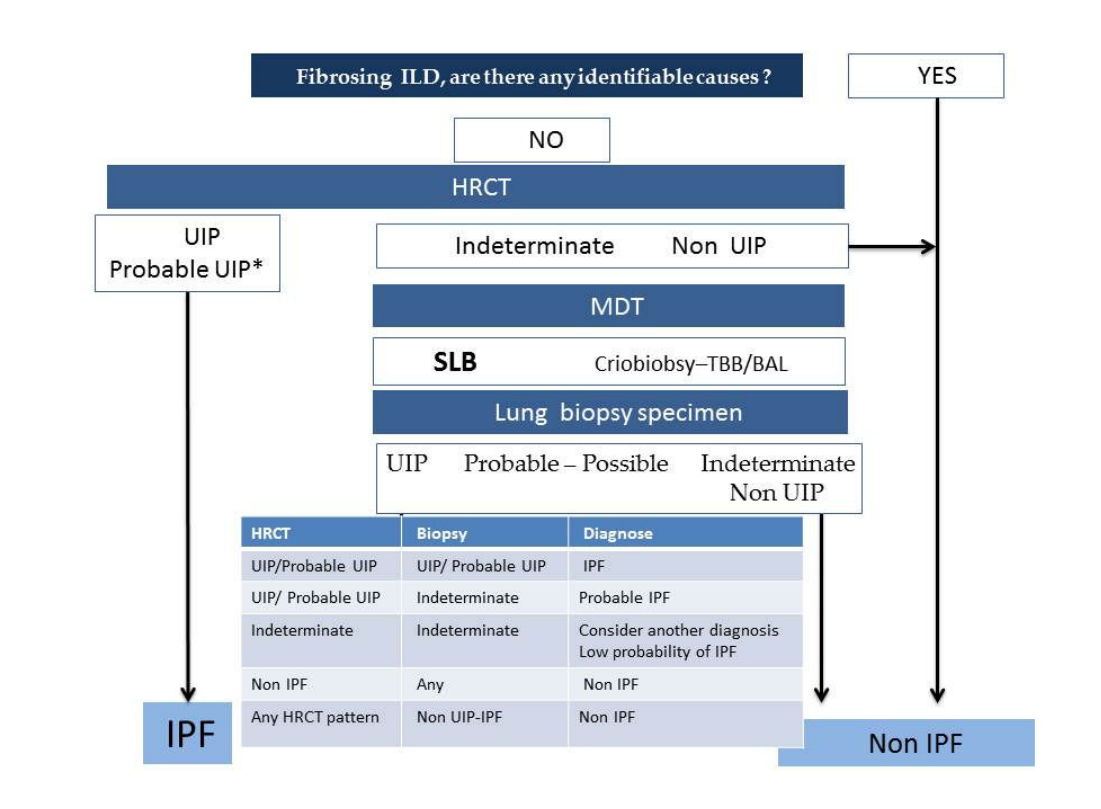
Figure 1. Flow chart to diagnose idiopathic pulmonary fibrosis (IPF). ILD: interstitial lung disease; HRCT: high-resolution computed tomography; UIP: usual interstitial pneumonia; MDT: Multidisciplinary team; SLB: surgical lung biopsy; TBB: transbronchial forceps biopsy; BAL: bronco alveolar lavage; *: patient with “probable UIP pattern” in high-resolution computed tomography (HRCT) and clinical high suspicion of IPF (patient over 60 years, smoking history, and unknown etiology do not require a